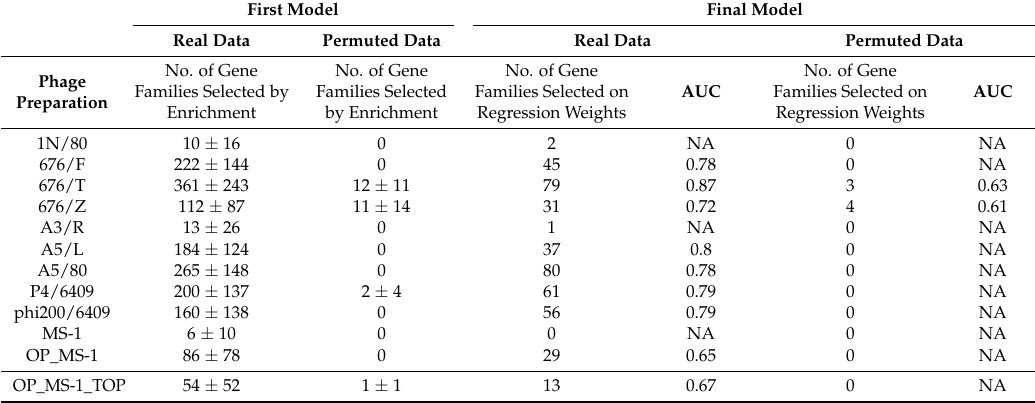
Table 2. Summary of the modelling results for real and permuted data. The “First Model” section reports the results of the first filtering procedure based of association analyses. The “Final Model” section gives the result of the second filtering procedure based on regression model fitting combined with consistency constraints. The area under the curve (AUC) is used as performance measure of the final model. The number of gene families selected given in the left part of the table is calculated as the average ± standard deviation across the five folds. If less than two gene families were selected based on regression weights, a final model could not be trained and the associated AUC is reported as NA (not